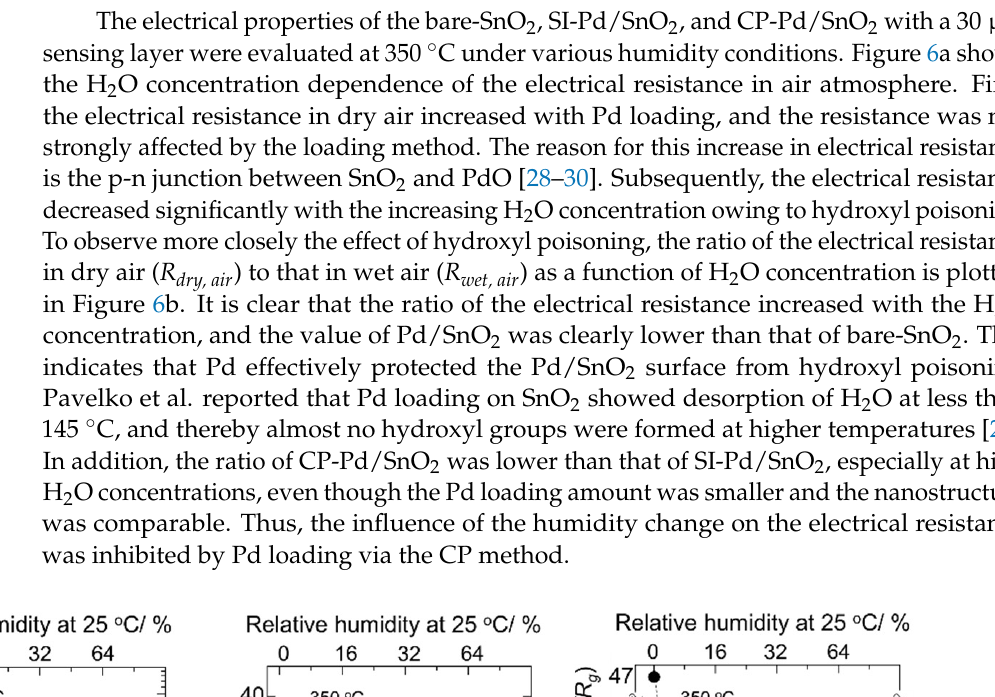
Figure 5. XPS spectrum of Pd 3d using SI-Pd/SnO 2 and CP-Pd/SnO 2 .